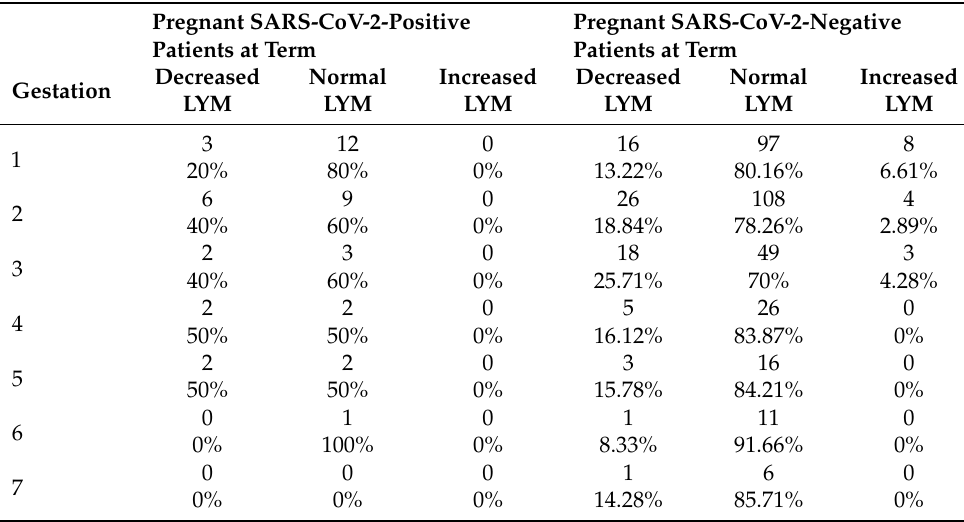
Table 7. Number and percent of pregnant patients with a normal, increased, and decreased number of lymphocytes, as regards